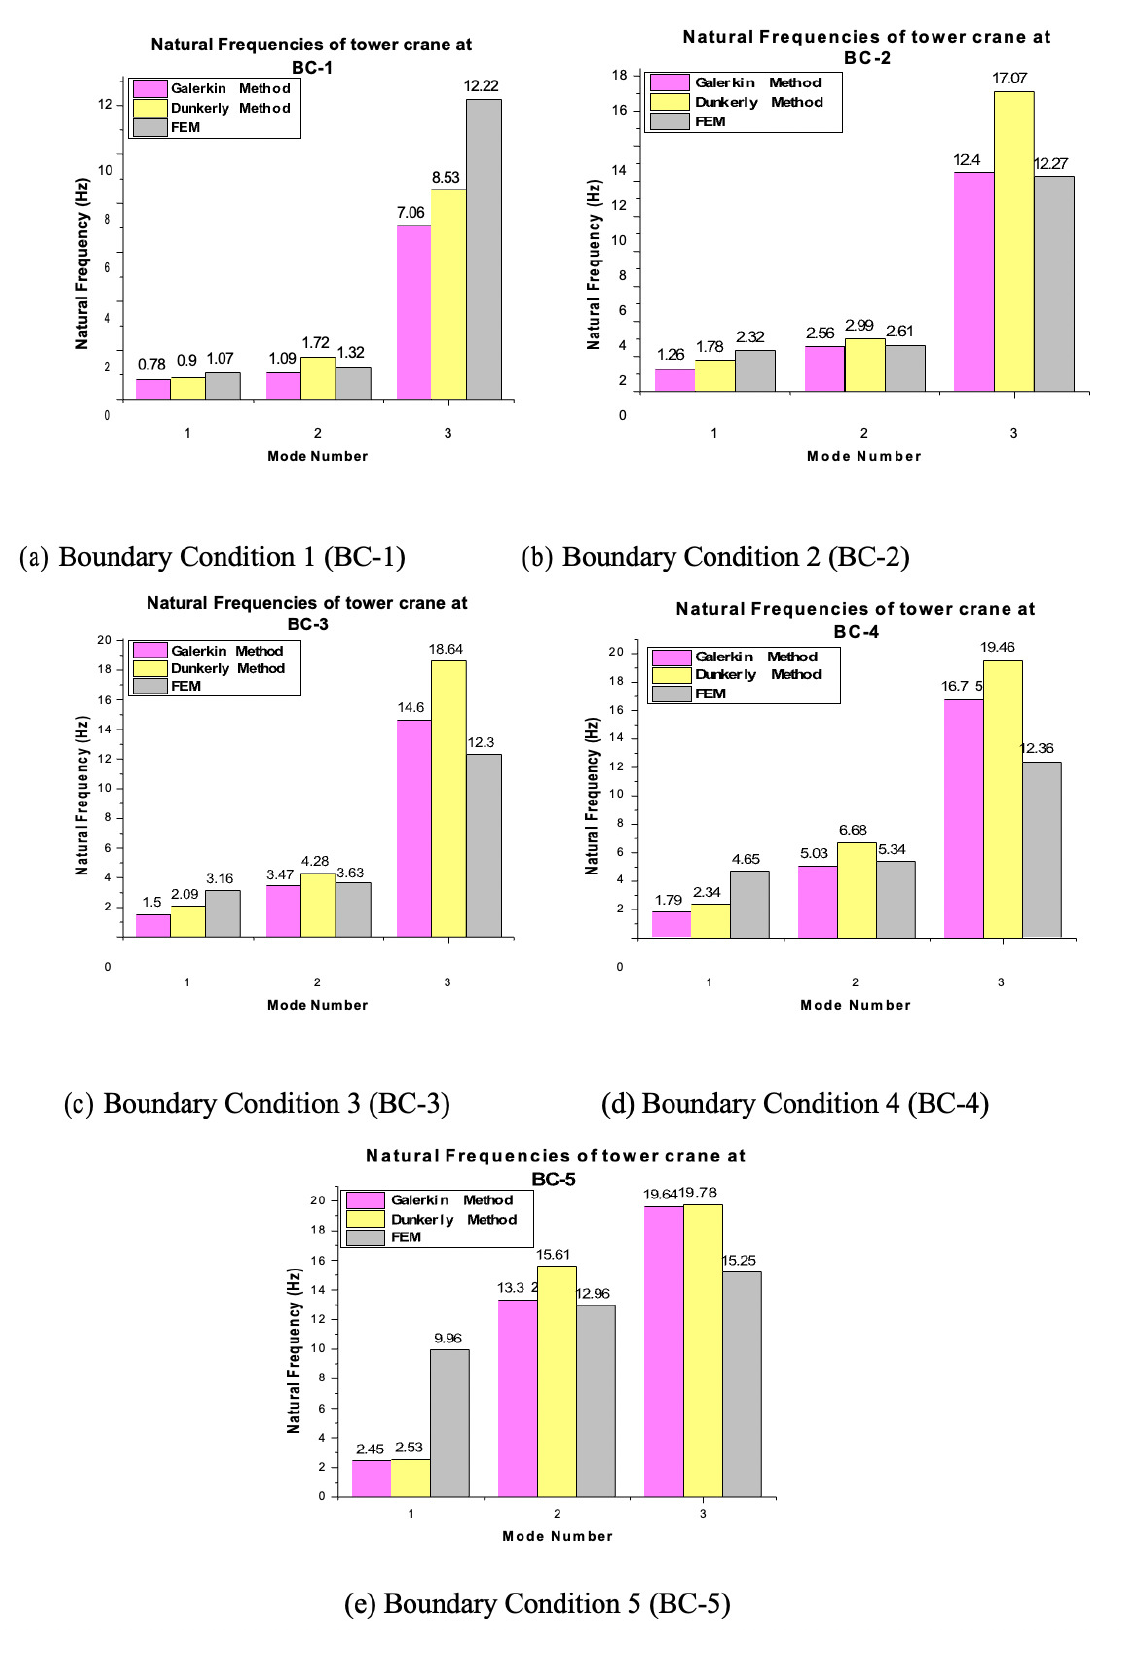
Figure 15. Natural frequencies of tower crane with different boundary